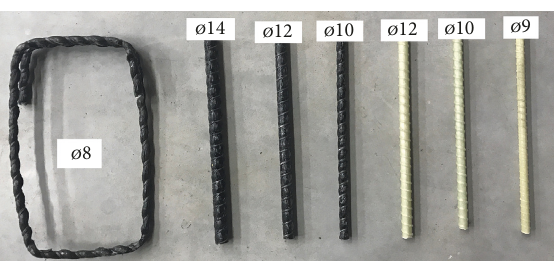
Figure 2: Samples of GFRP longitudinal and transverse